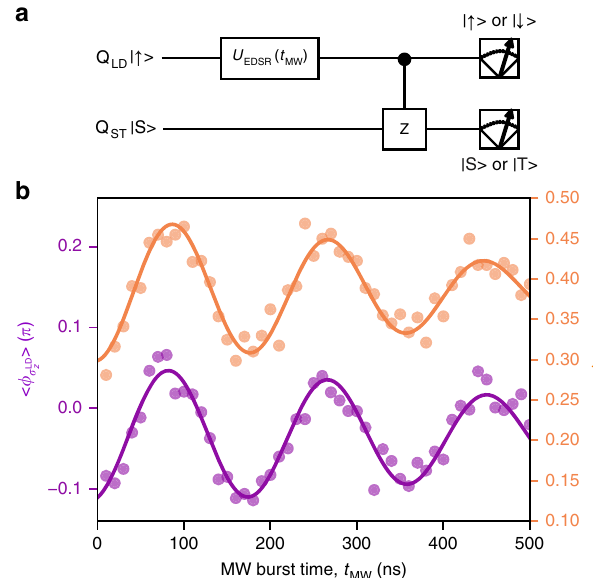
Fig. 4 Demonstration of the controlled-phase gate for arbitrary control qubit states. a The circuit for CPHASE gate demonstration. Here t int is fi xed at 4.2 ns where ϕ C ≈ π (Fig. 3b). b t MW dependence of the spin-down LD z probability of Q LD , P ↓ (yellow) and the averaged ϕ σ , ϕ σ D E LD z LD z ¼ (cid:3) π h σ LD i = 2 obtained by the circuit shown in Fig. 4a. ϕ σ z LD z